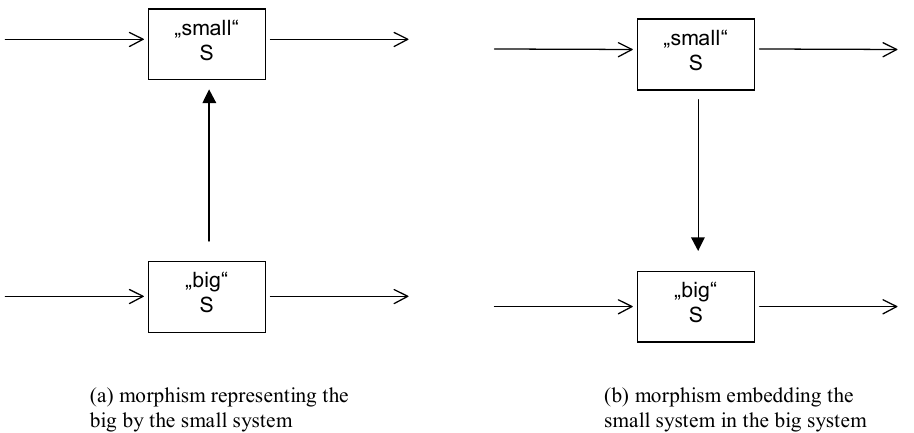
Figure 12. Morphisms between big and small systems [10]. Visual representation of the formal mapping of abstraction from the big system to the small system ( a ) and elaboration of the small system to the big system ( b ).